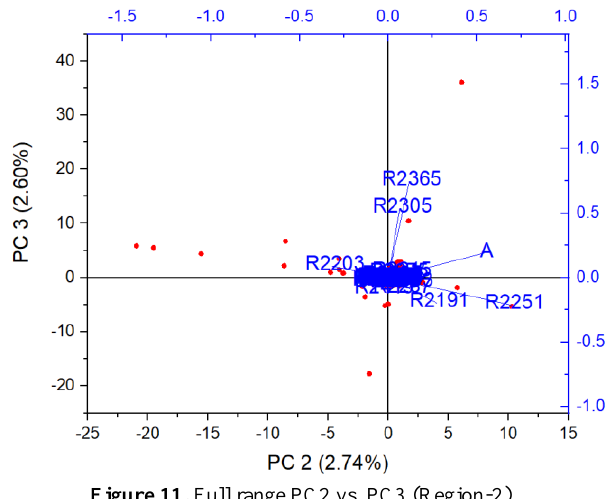
Figure 11. Full range PC2 vs. PC3 (Region-2)